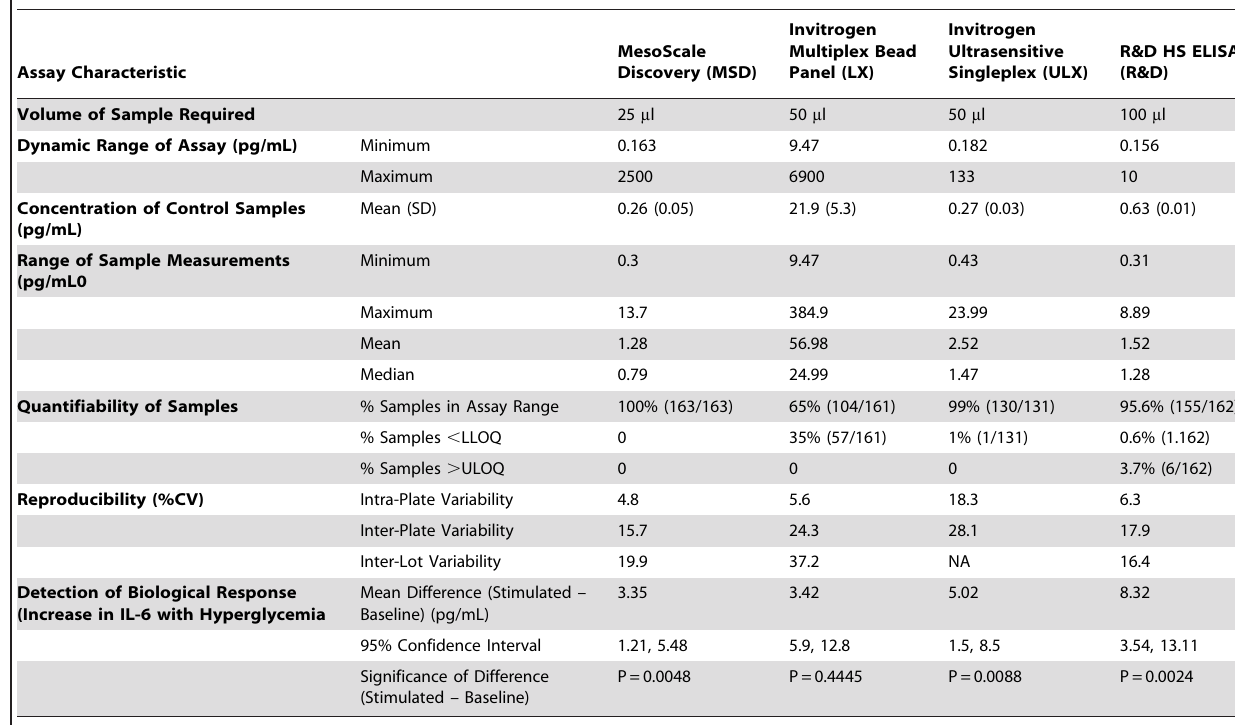
Table 1. Performance metrics of four IL-6 immunoassays.